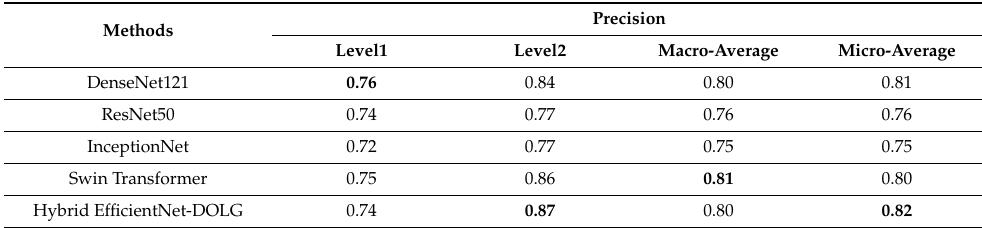
Table 7. Comparing results between the five deep learning models on COVID-19 severity assessment task with respect to precision metric.